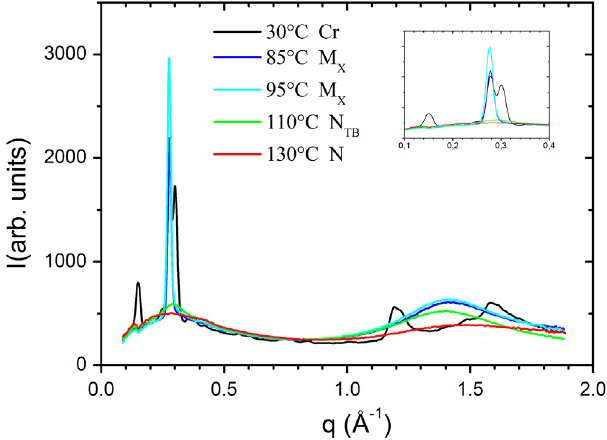
FIG. 18. Growth of N monochiral domains (on the left side) TB in the N phase (on the right side) at the N - N transition of BP12 TB ( T ¼ 108 . 9 °C, d ¼ 9 . 8 μ m). To evidence the alternating sign of the chirality of the domains, they are observed in monochromatic light, λ ¼ 546 nm, between crossed polarizers (white double- headed arrows) rotated at 3° with respect to the rubbing direction r . (Scale bar 100 μ